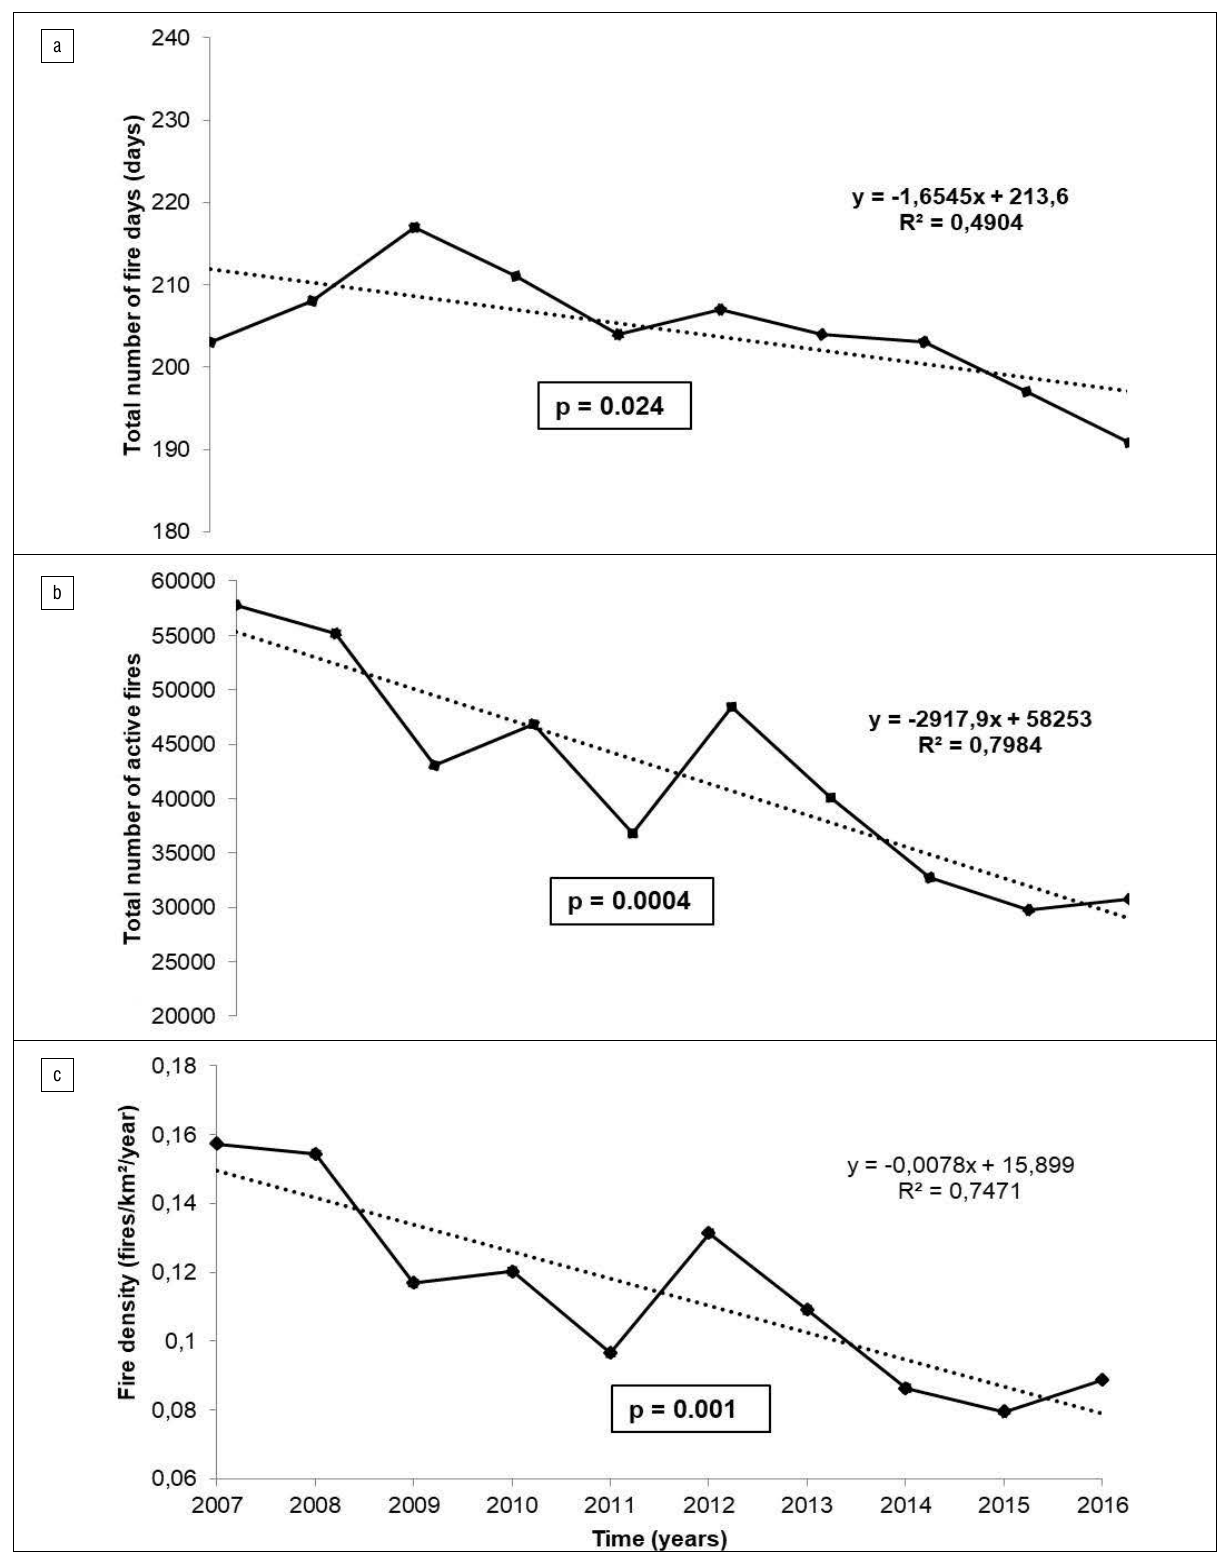
Figure 5: Yearly fire events in Côte d’Ivoire from 2007 to 2016: (a) total number of fire days; (b) total number of active fires; (c) fire density per